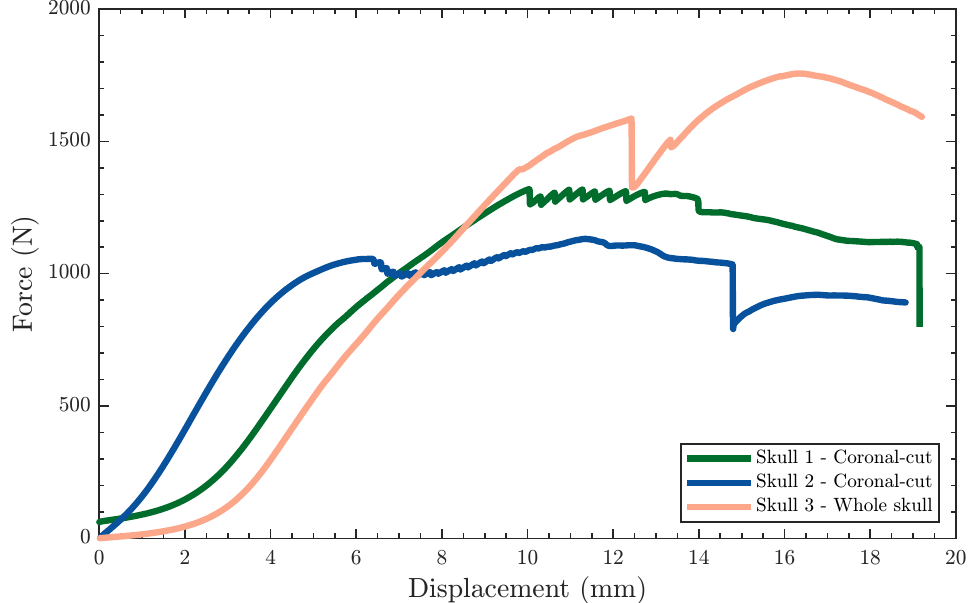
Figure 8. Force-displacement curves showing the response of the surrogate skulls to frontal point- loading tests.